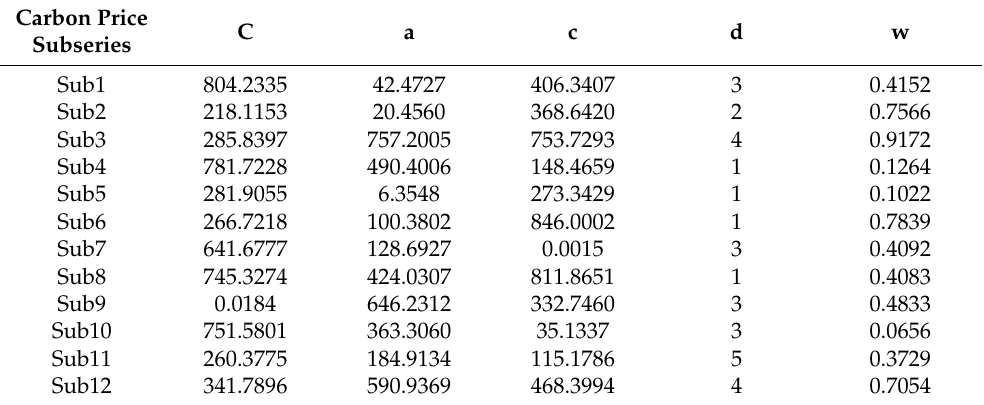
Table 5. The results of the optimization of the parameters of HKELM for subseries of carbon